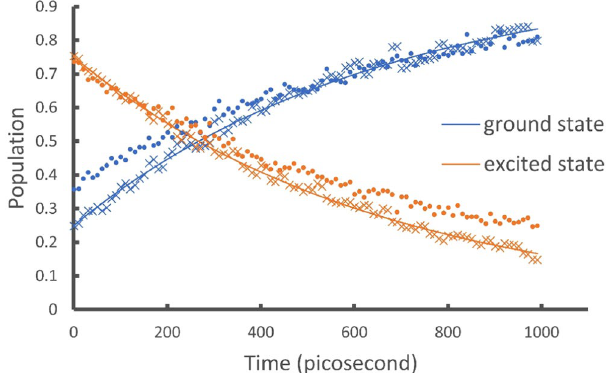
Figure 1. Showing the populations of the ground and excited states for the amplitude damping model. The smooth lines are obtained by classical numerical calculations of the output vectors. These agree exactly with analytic results and are used as benchmarks. The crosses are obtained by the IBM Qiskit simulator. The dots are obtained by the IBM Q 5 Tenerife device. The quantum circuits include 2 qubits and on average 13 elementary gates (see Fig. 4 for an example and the SI for all the